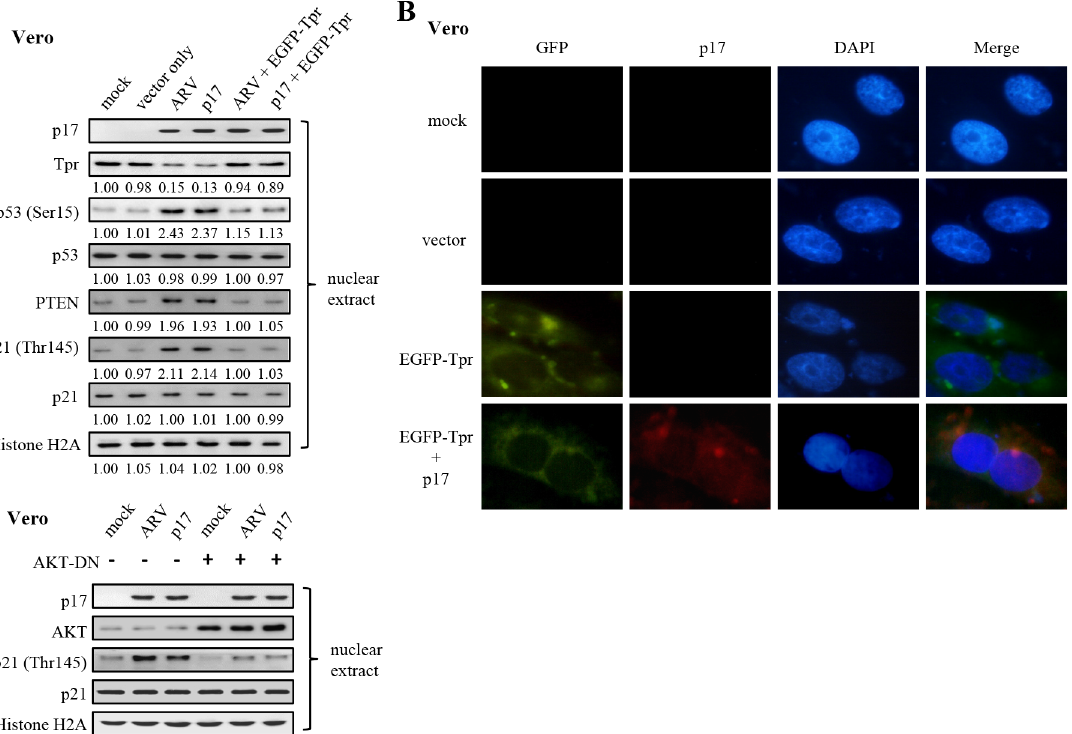
Fig 4. A rescue experiment by overexpression of EGFP-Tpr in ARV-infected and p17-transfected vero cells as well as examination of AKT required for p21 phosphorylation. (A) To carry out a rescue experiment by overexpression of EGFP-Tpr in ARV-infected and p17-transfected vero cells, cells were transfected with the EGFP-Tpr plasmids for 48 hours, and then either infected with ARV at an MOI of 10 or p17 transfection for 24 hours. Whole cell lysates were collected for Western blot assays. Histone H2A was used as a loading control. The activation and inactivation folds indicated below each lane were normalized against those in mock controls (cell alone). The levels of indicated proteins in the mock control were considered 1-fold. (B) Representative images of vero cells transfected with plasmids overexpressing EGFP-Tpr. Vero cells were transfected with negative controls (mock and vector only) or EGFP-Tpr plasmid for 48 hours and then visualized by immunofluorescence following nuclear DAPI staining. In addition, another set of cells were transfected with EGFP-Tpr for 48 hours and then transfected with p17 for 24 hours. Cells were fixed and processed for immunofluorescence staining of p17. Colocalization of EGFP-Tpr and p17 was observed under a fluorescence microscope. Scale bar: 10 um . (C) To examine whether AKT kinase activity is directly required for p21, we used an Akt DN to inhibit AKT in Vero cells. The levels of p-p21 (T145) in the nucleus were examined in ARV-infected and p17-transfected cells in the presence or absence of an Akt DN. Histone H2A was used as a loading